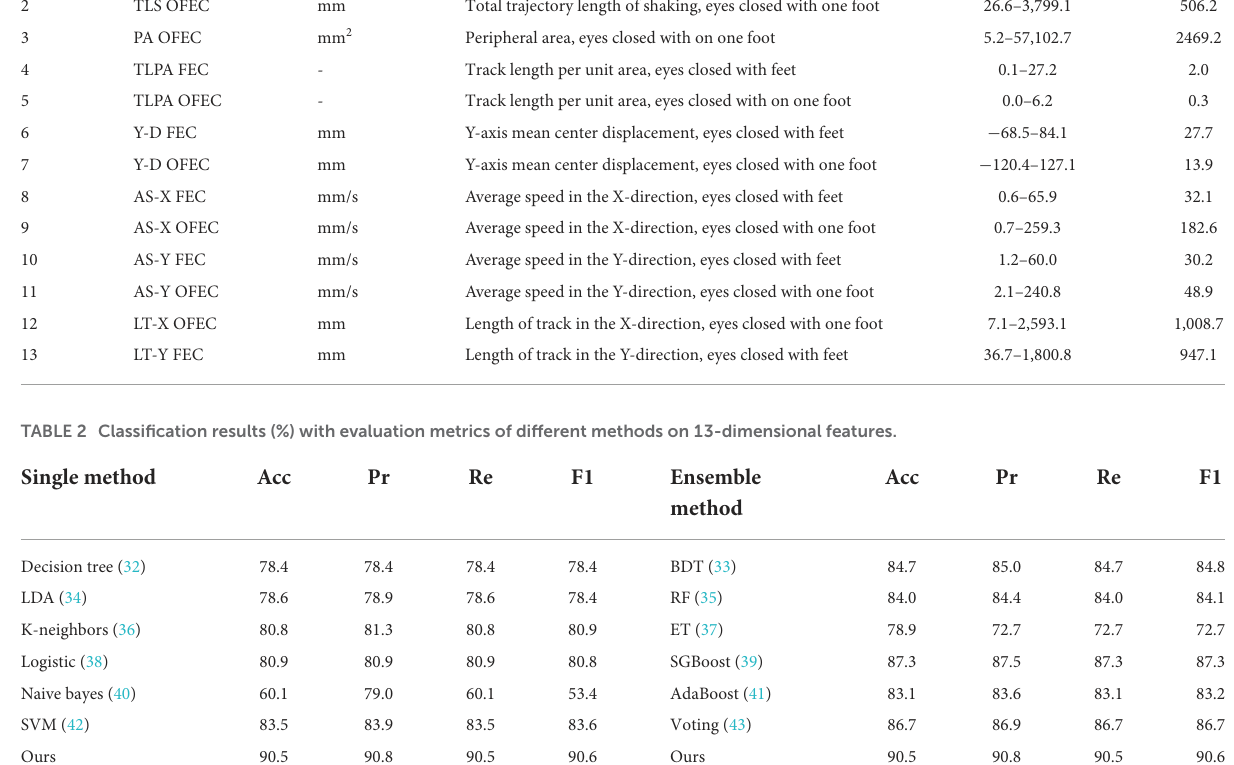
ability in the data set, namely: high, medium, and low. For the prediction of the balance level, we changed the output layer dimension of the proposed neural network to 3 to perform the classification task. The input to the network is the selected 13- dimensional features in Table 1. As shown in Table 2, compared with other machine learning models like Decision Tree (32), Linear Discriminant Analysis (LDA) (34), K-Neighbors (36), Logistic [ (38)], Naive Bayes (40), and Support Vector Machines (SVM) (42), our method has the highest accuracy, recall, precision, and F1-score evaluation metrics, reaching 90.5,